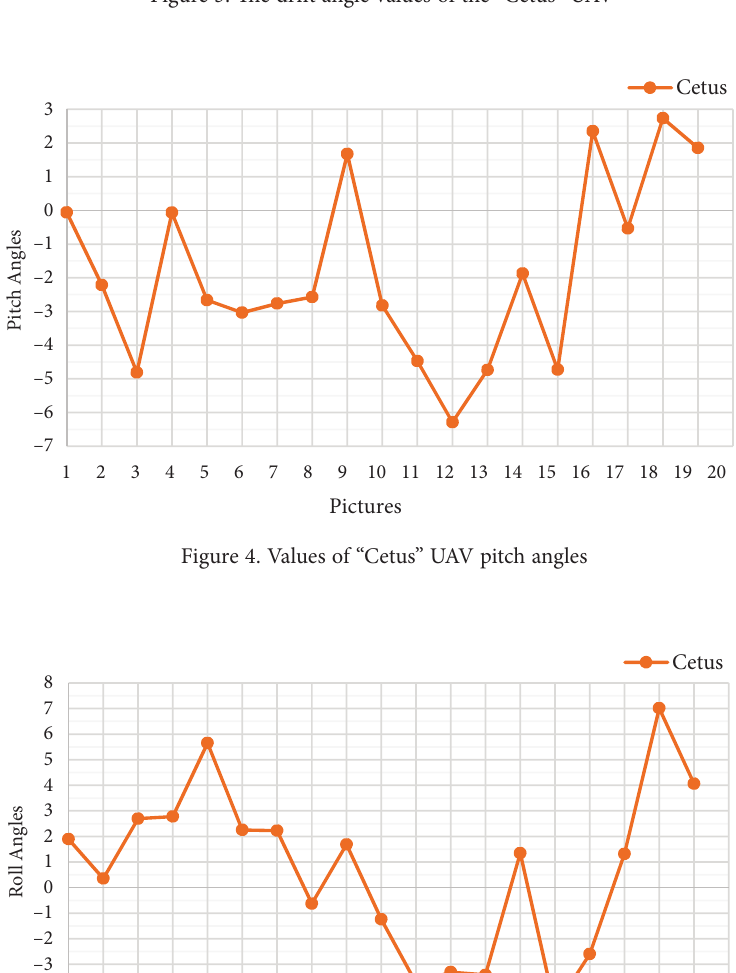
Figure 3. The drift angle values of the “Cetus” UAV